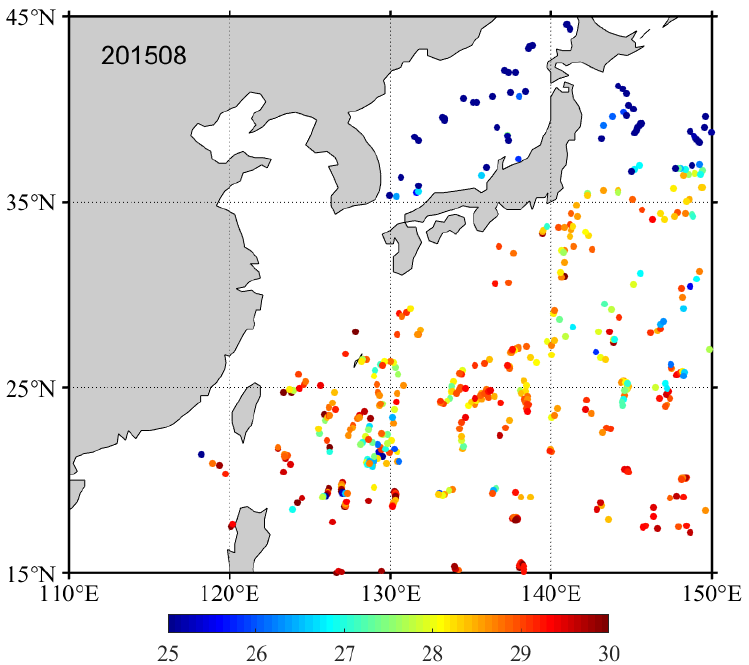
Figure 1. Study area, where the dots represent the location of the ARGO buoys (SST, colored shading; °C). The figure shows the overlay of daily ARGO buoy SST observation point locations in the study area in August 2015.